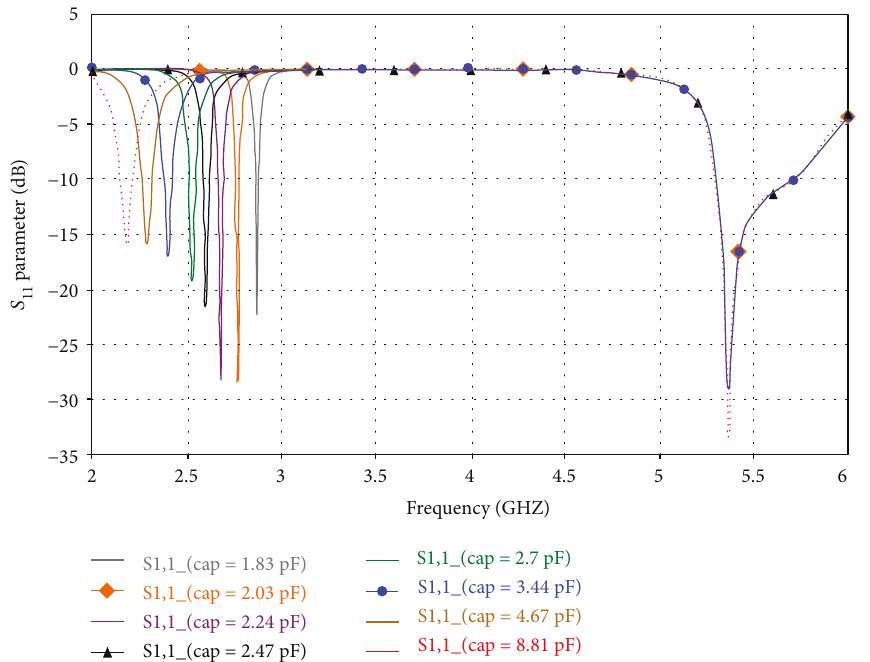
Figure 10: S 11 parameter of the ideal case using